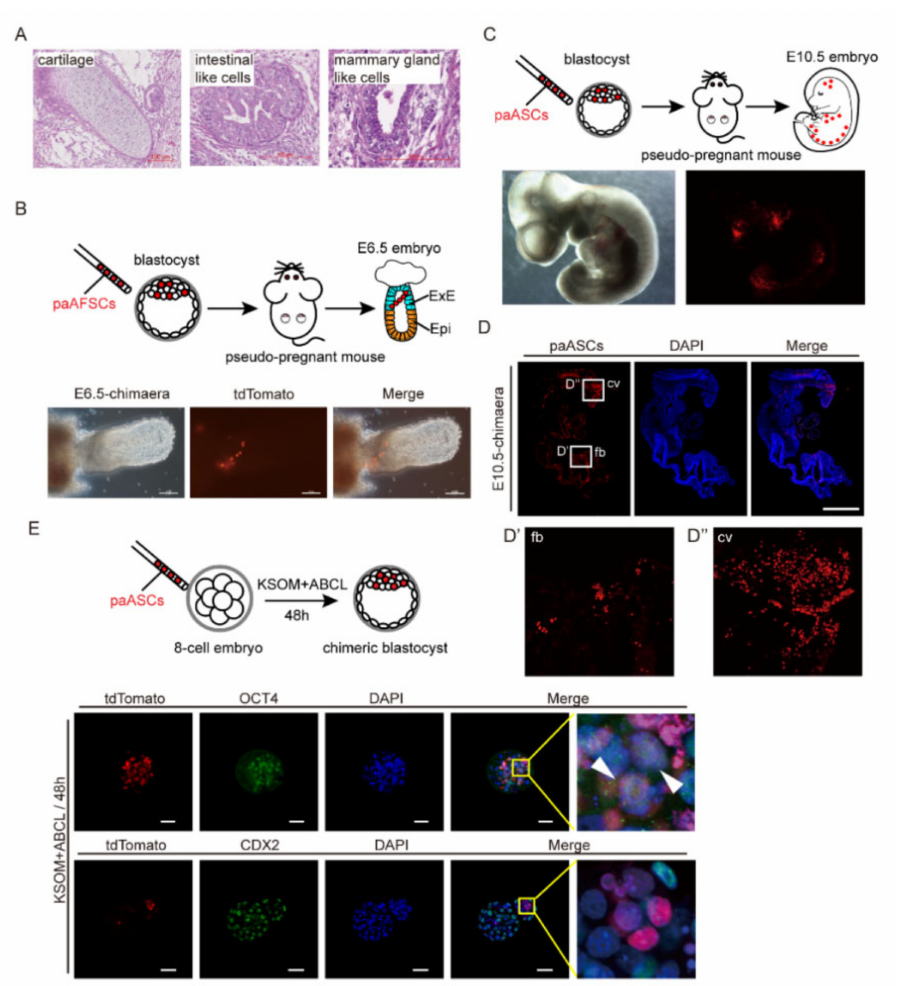
Figure 4. Developmental potential of paAFSCs and paASCs in vivo. ( A ) Teratoma derived from paASCs. The left panel shows a cartilage-like structure (mesoderm), the middle panel shows an intestinal-like structure (ectoderm), and the right panel shows a mammary gland-like structure (endoderm); scale bars: 100 µ m. ( B ) The paAFSCs with tdTomato contributed to the extra-ectoderm of the E6.5 chimaera; scale bars: 100 µ m. ( C ) The paASCs with tdTomato contributed to the fetus of the E10.5 chimaera. ( D ) Sections of the E10.5 chimaera were stained with the RFP expressed by paASCs. ( D (cid:48) ) and ( D” ) mark the forebrain (fb) and caudal vertebra (cv) of fetus, respectively; scale bars: 1 mm. ( E ) Immunostaining for OCT4 and CDX2 of blastocysts which developed from 8-cell stage embryos with injected paASCs for 48 h of culturing in KA in vitro; scale bars: 50 µ m. The white arrows pointed to the paASCs with tdTomato reporter also expressed